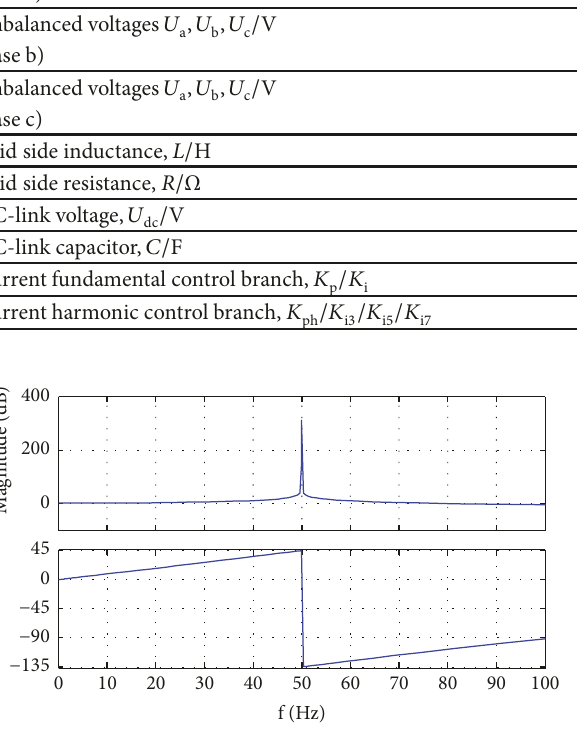
Figure 5: The bode diagram of 𝐺 𝑓 (𝑠) .